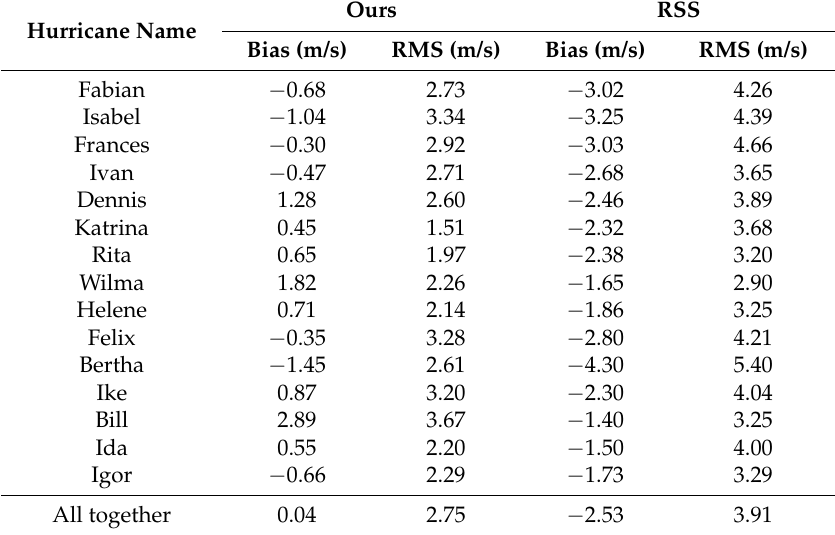
Table 3. Statistics of errors between the new retrieved wind speed and H*wind wind speed and between RSS all-weather wind speed and H*wind wind speed for H*wind wind speeds above 20 m/s for the selected hurricanes from 2003 to